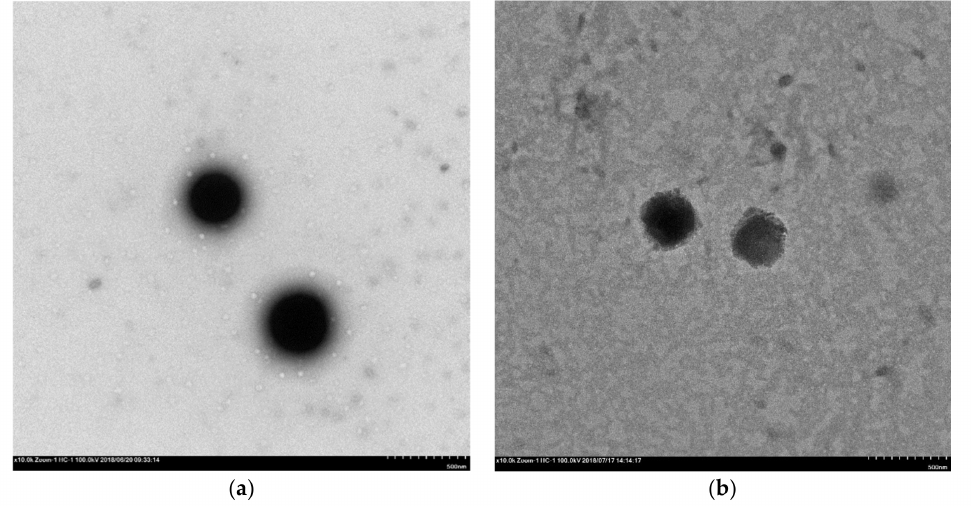
Figure 1. TEM images of the P4G6 ( a ) and P6G4 ( b ) PECs. The PECs were dropped to carbon-coated cooper grids. After the PECs were attached onto the carbon cooper grids, excess PECs were removed. The attached PECs were then stained with 1% sodium phosphotungstate aqueous (PTA) solution. The 1% PTA solution was dropped to the grids and excess PTA solution was removed after staining. The TEM grids were dried in a vacuum oven and stored at room temperature until observation (scale bar: 500 nm).